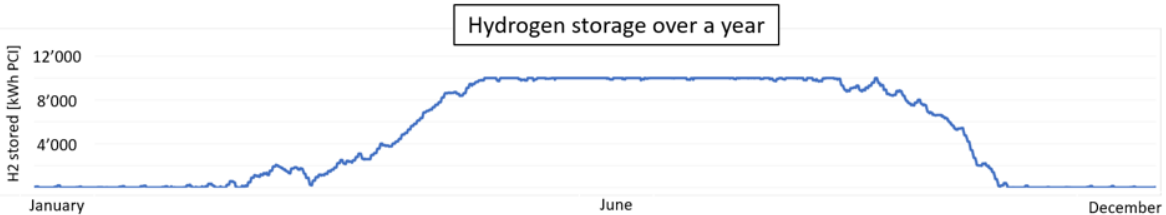
Figure 4. Amount of H stored over a one-year period time using the max SS ratio mode. 2